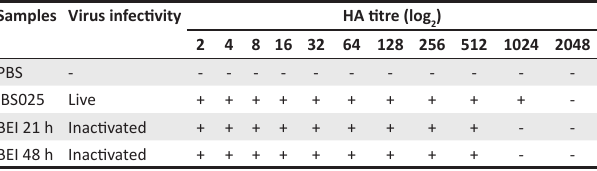
TABLE 2: Effect of binary ethylenimine inactivation on the viral hemagglutination assay titre. Samples Virus